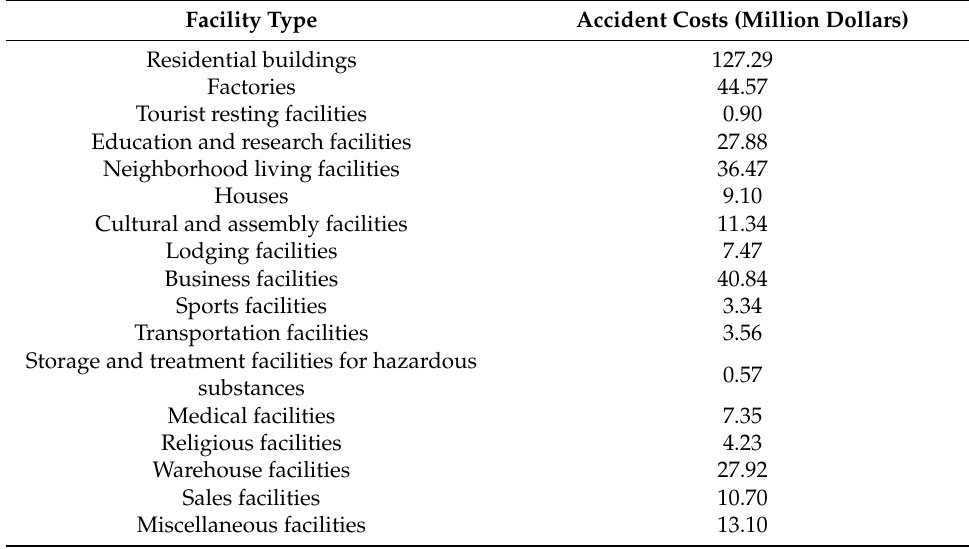
Figure 2. Comparison between accident probability and frequency for 17 construction facility types. Table 5. Analysis of accident costs for 17 construction facility